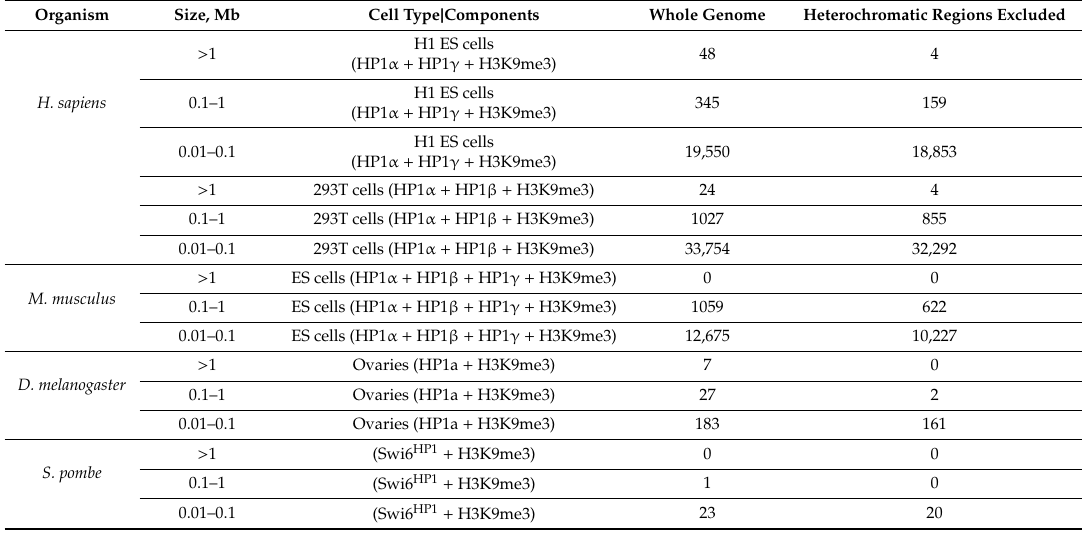
Table1. Heterochromatin- like domains / complexesin Homosapiens , Musmusculus , Drosophilamelanogaster and Schizosaccharomyces pombe